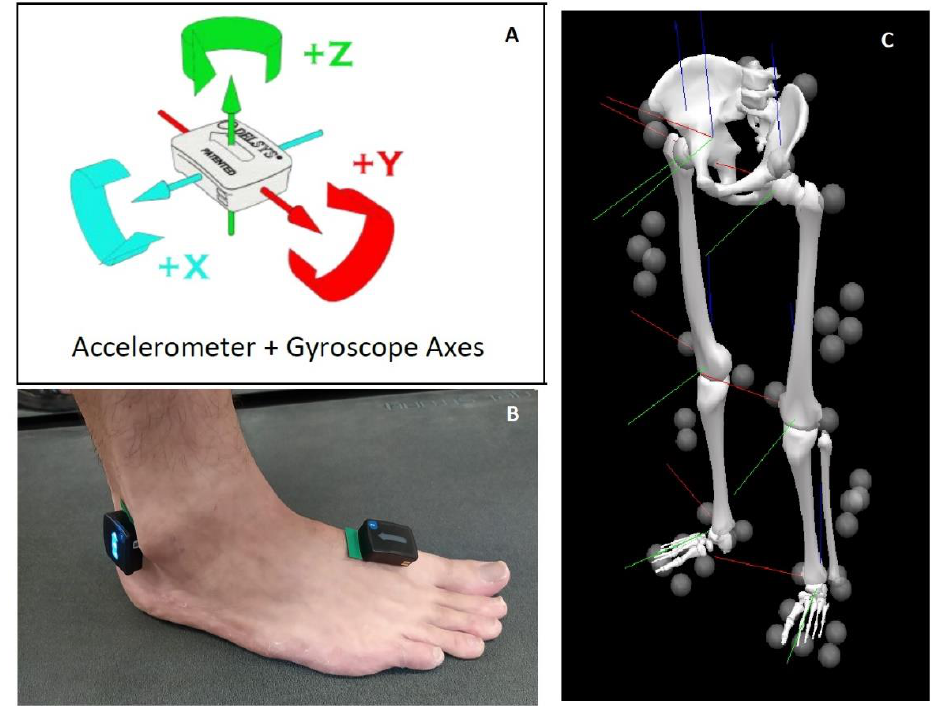
Figure 1. ( A ) Delsys Avanti’s sensor with accelerometer and gyroscope axes (reprinted with permission from Trigno Wireless Biofeedback System User’s Guide, MAN-031-1-4, Delsys Inc.); ( B ) Heel and metatarsal Inertial Measurement Units position; ( C ) Reflective markers position. The red, green and blue lines represent the lab’s X, Y and Z coordinates, respectively .